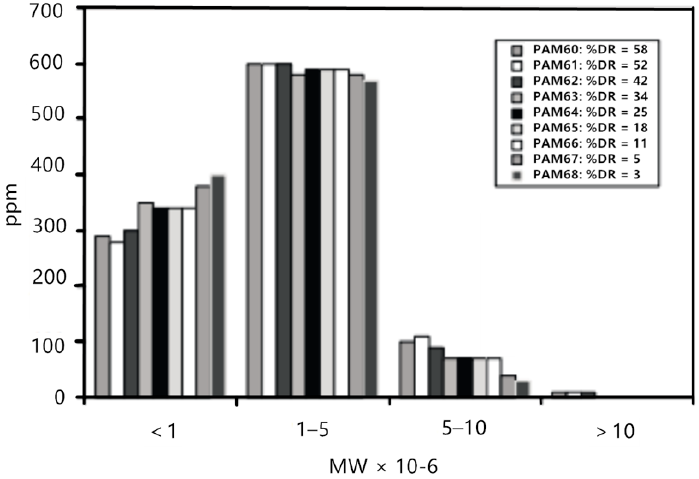
Figure 4. Molecular weight distribution for 1000 ppm polyacrylamide (PAM) solutions from channel flow experiments under drag reduction conditions [29].